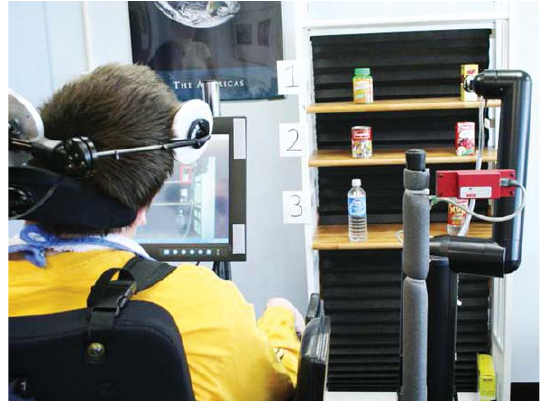
Fig. 9. Experimental setup with single switch scanning. P5 used Cross Scanner [35] single switch scanning software and activated the scanning with a head